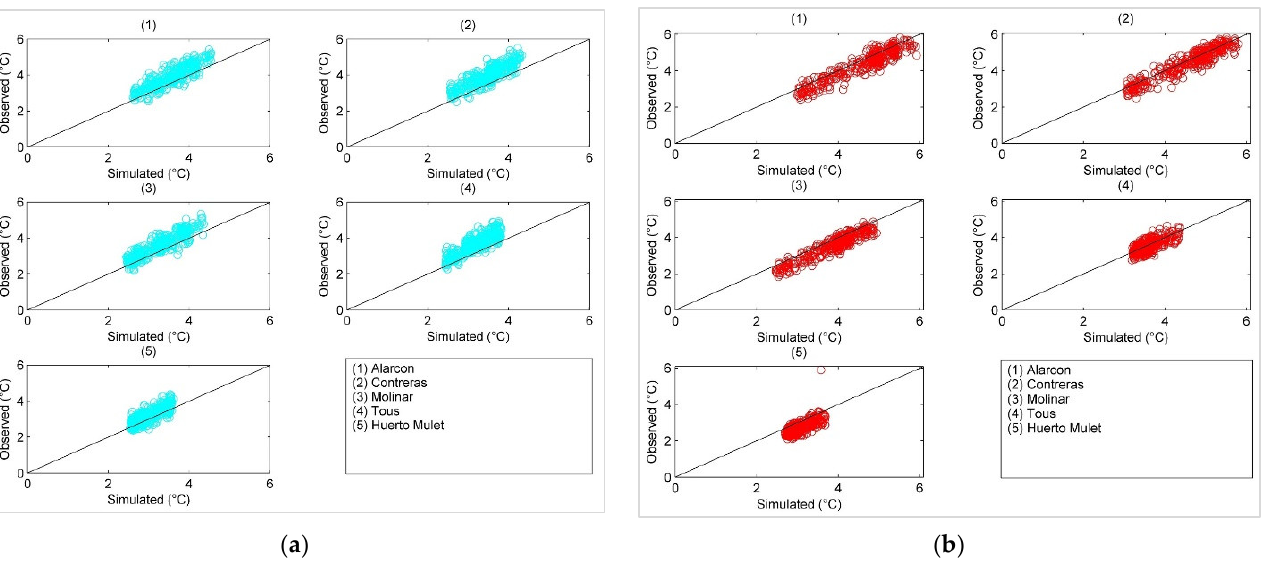
Figure 10. Scatter plots for observed standard deviations versus generated (mean 66 years observed and 1000 simulated series) for two models: ( a ) maximum temperature for each calendar day (blue) and ( b ) temperature range for each calendar day (red).